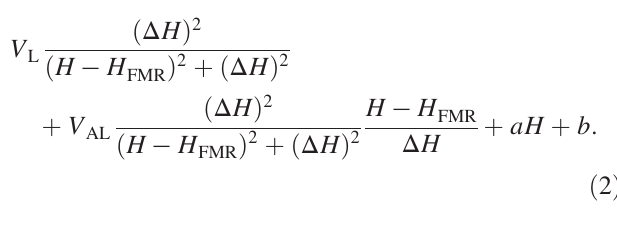
FIG. 2. (a) Device resistance as a function of the MgO barrier thickness ( t 0.94 nm and 189 Ω , respectively. The magnetic-field angle definition ( θ H ) is depicted in Fig. 3(a). (c) Magnetoresistance ratio as a function of t MgO